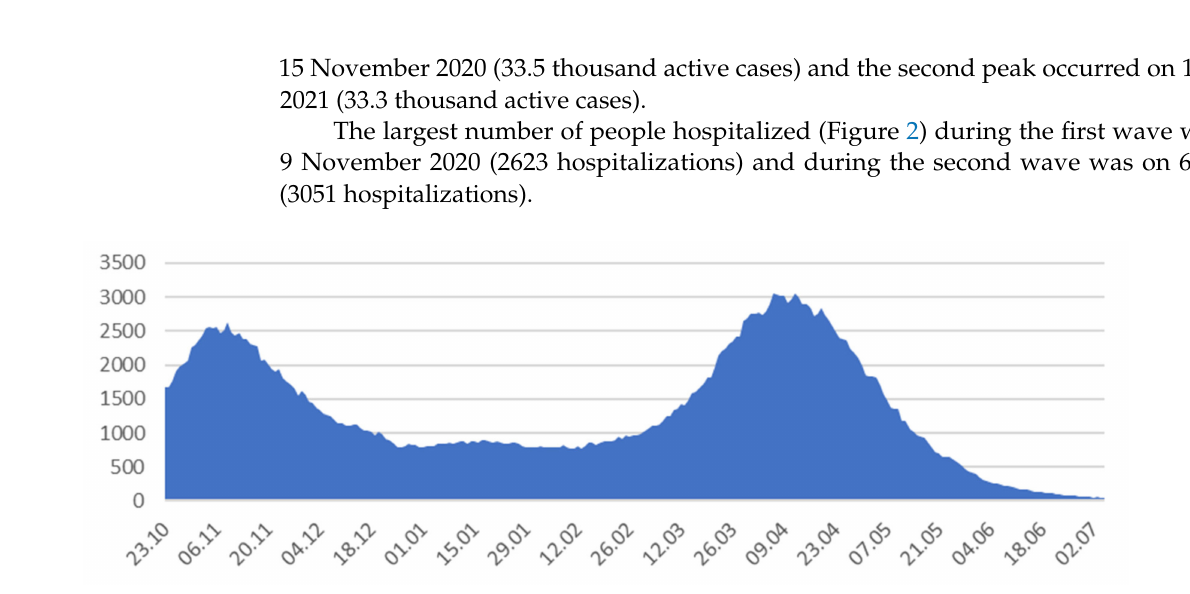
Figure 2. Number of people hospitalized in Małopolska. Source: Data collected on the basis of reports provided by the Ministry of Health, data from the WSEZ, PSSE, Voivodship Offices, and data obtained via requests for access to public information.